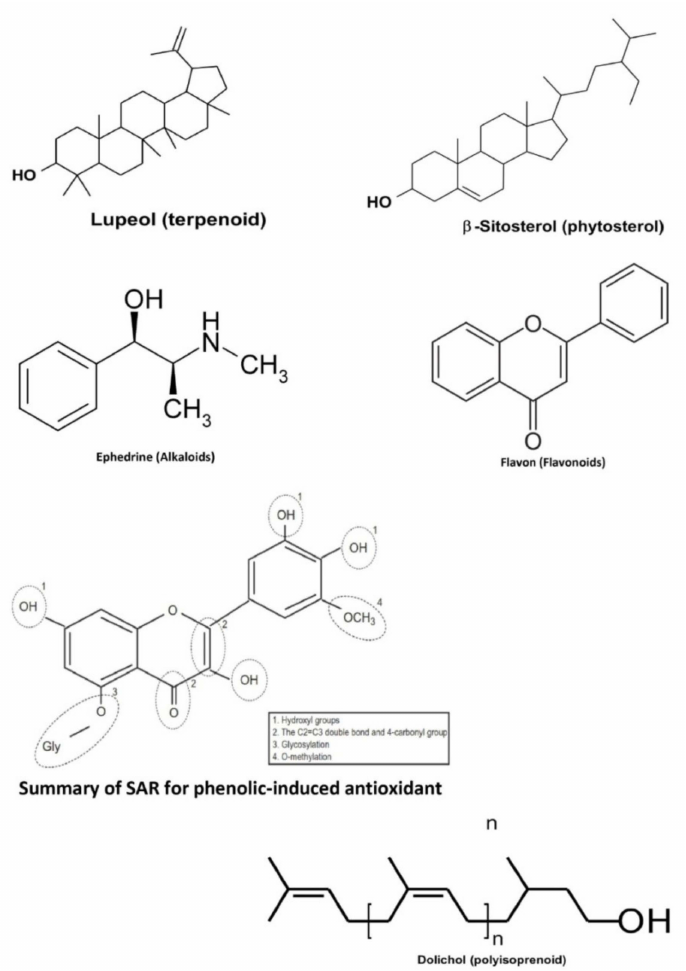
Figure 2. The basic structure for one of the various derivatives from bioactive compounds of terpenoids, phytosterols, alkaloids, phenolics, flavonoids, and